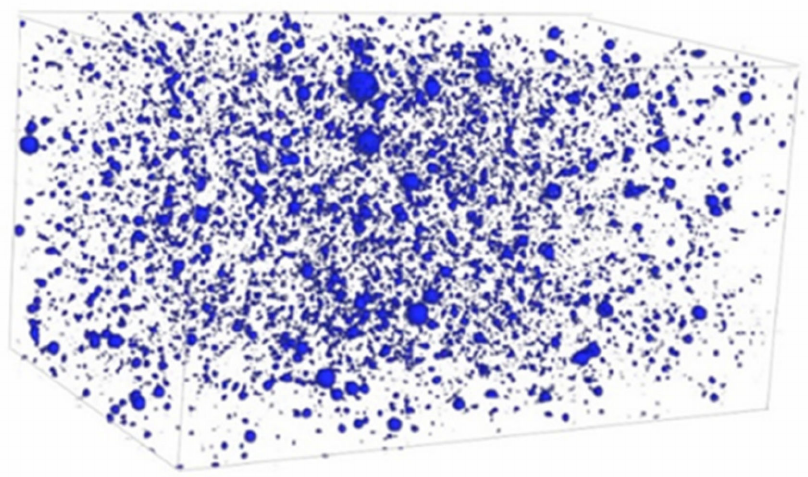
Figure 5. The three-dimensional reconstruction diagram of the pore phase with the mixture W2L1- 28 d.